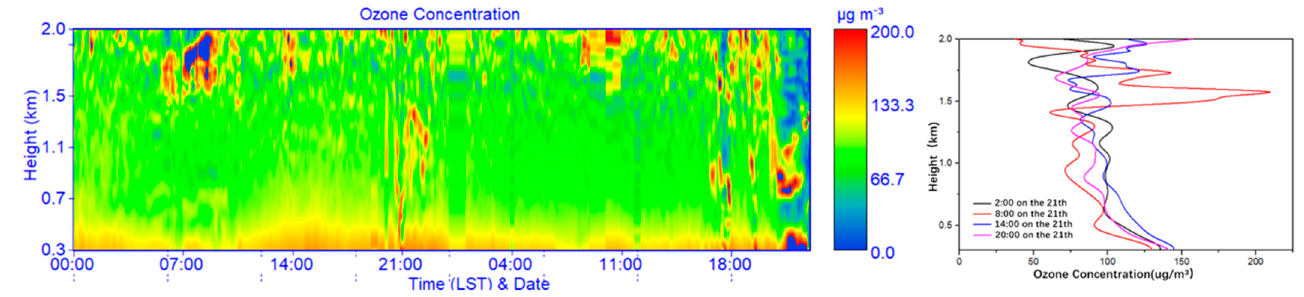
Figure 7. Ozone 21–22 May represents typical cumulative ozone pollution. Left: the changing trend of ozone concentration distribution; Right: ozone concentration vs. height.